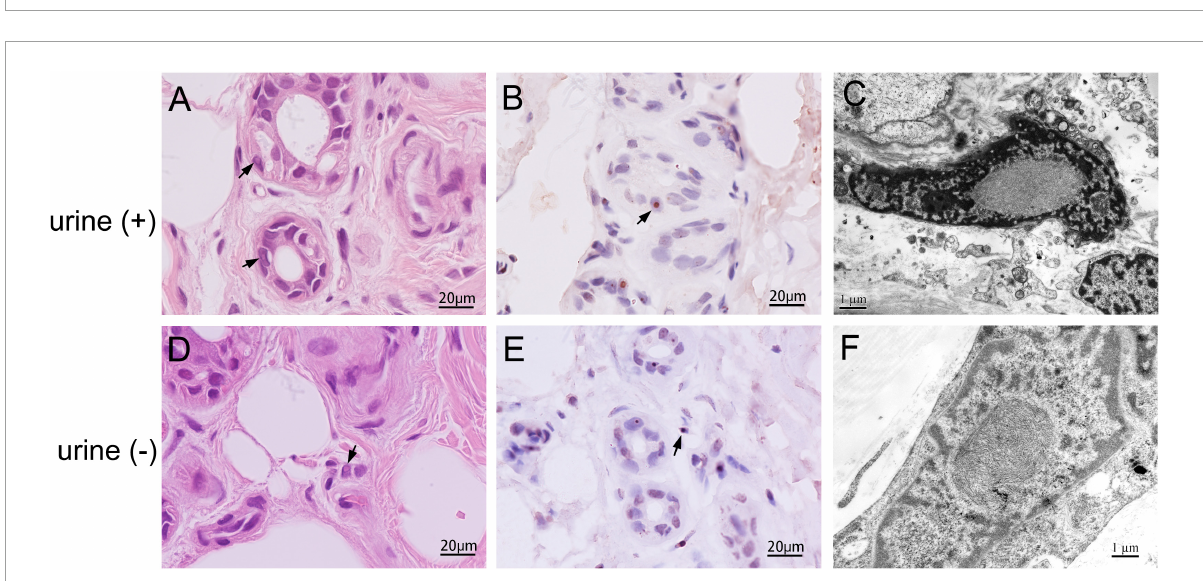
FIGURE3 Skin pathology of neuronal intranuclear inclusion disease (NIID) patients with positive and negative urine sediment. H&E staining showed eosinophilic intranuclear inclusions in the nuclei of epithelial cells of the skin sweat gland ducts (Panels A,D , arrow); anti-p62 immunohistochemical staining showed positive intranuclear inclusions (Panels B,E , arrow); The intranuclear inclusions were seen as filamentous materials under electron microscope (C,F)